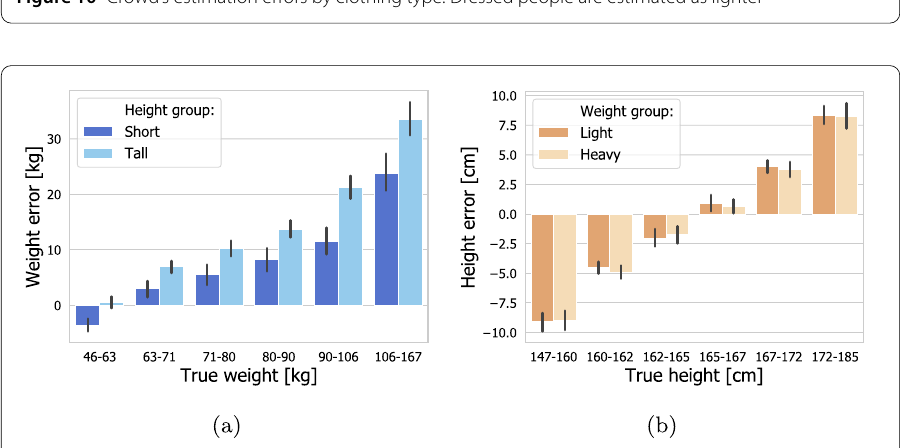
Figure 11 Dependence of the errors on the true measurements for female images. The black bars represent the 95% confidence